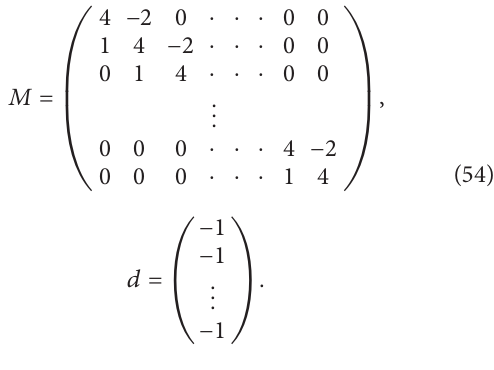
Table 2: Example 14: Numerical results for initial point 𝑥 0 = (0,0,...,0) 𝑇 and 𝜀 = 10 −4 . Algorithm 6 Dim ( 𝑛 )